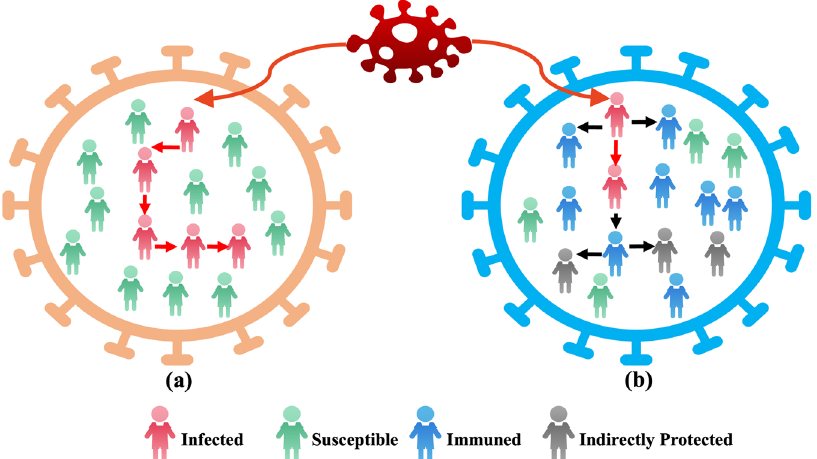
Fig. 10 Population immunity simulation in the CHIO model. Red represents infection cases, green represents susceptible cases, blue represents immune individuals, and grey represents indirectly protected cases. a This group had no immune individuals or isolated infection cases and did not increase social distance, which eventually led to case transmission. b This group has immune individuals and protective barriers, so it can effectively prevent the spread of the